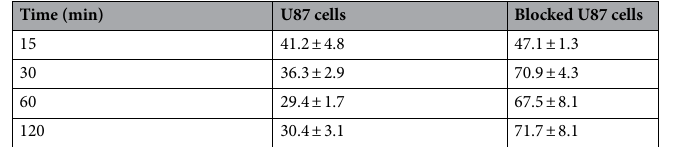
Table 2. Comparison of cell uptake of [ 18 F]AVT-011 between the U87 cells and blocked U87 cells (pre- incubated with Tariquidar